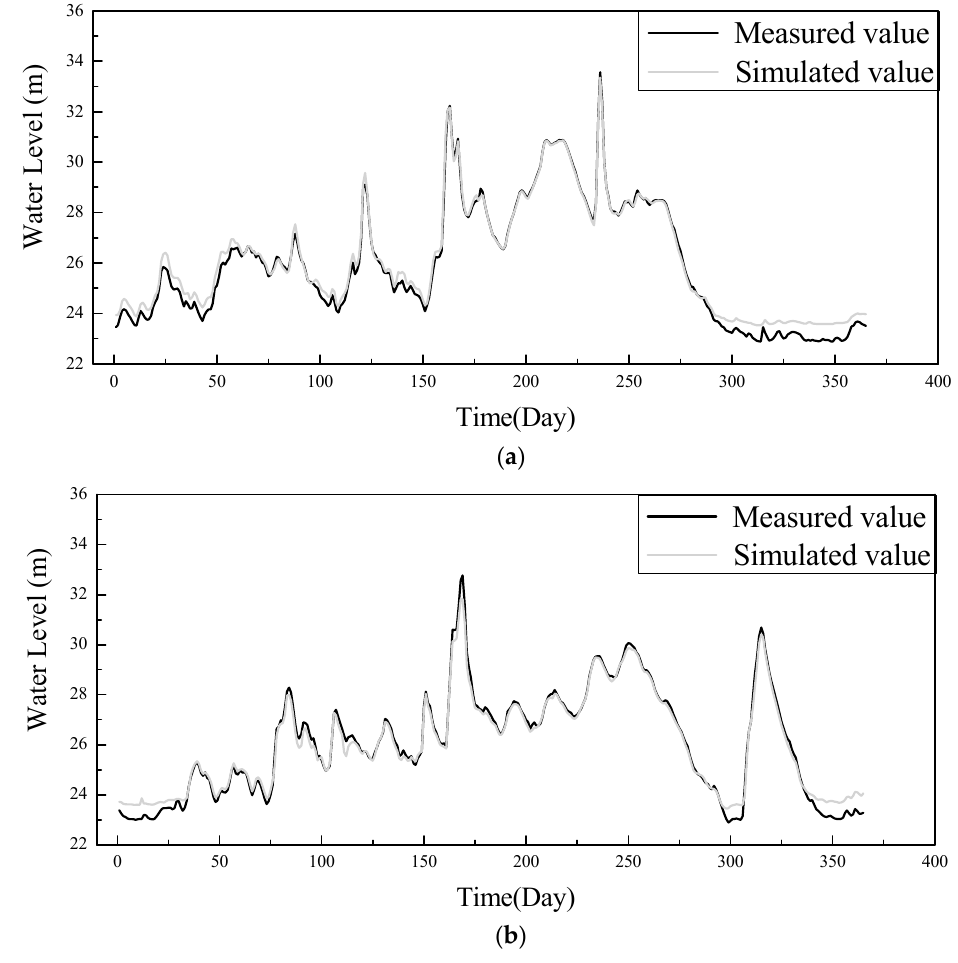
Figure 3. Simulated and measured daily runoff for model calibration and validation at CCCP (( a ) Calibration; ( b ) Validation).